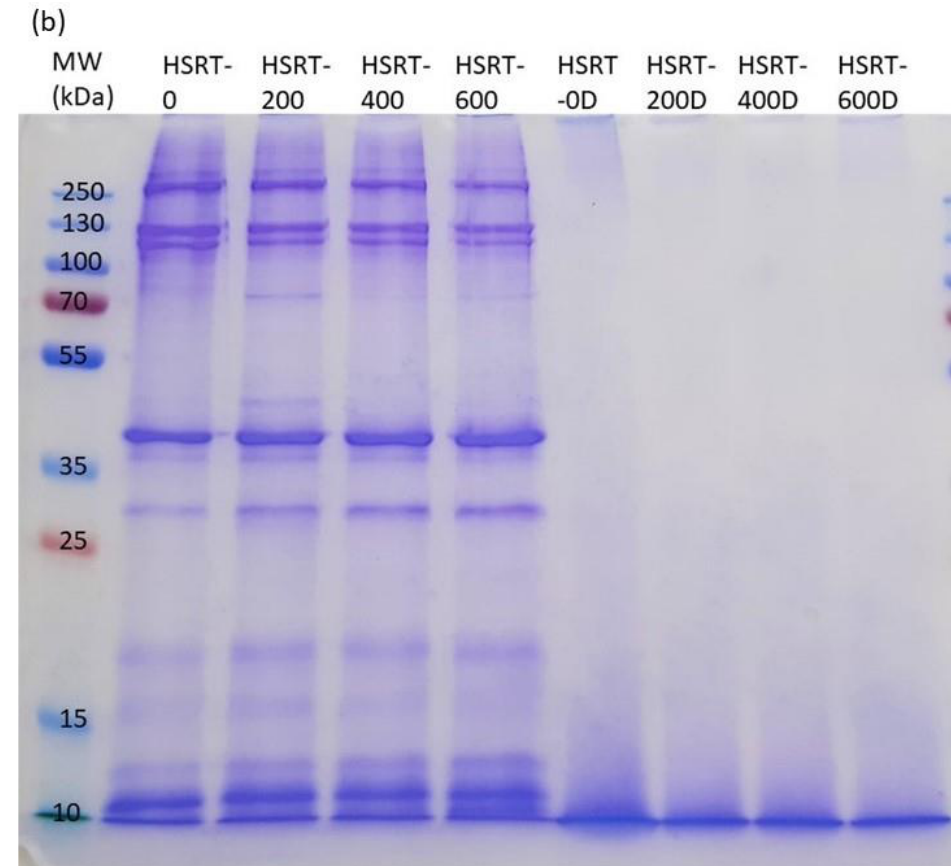
Figure 1. Soluble protein profiles and digestion patterns (D) in ( a ) cold smoked rainbow trout (CSRT) and ( b ) hot smoked rainbow trout (HSRT) samples treated with high pressure processing at 0, 200, 400, and 600